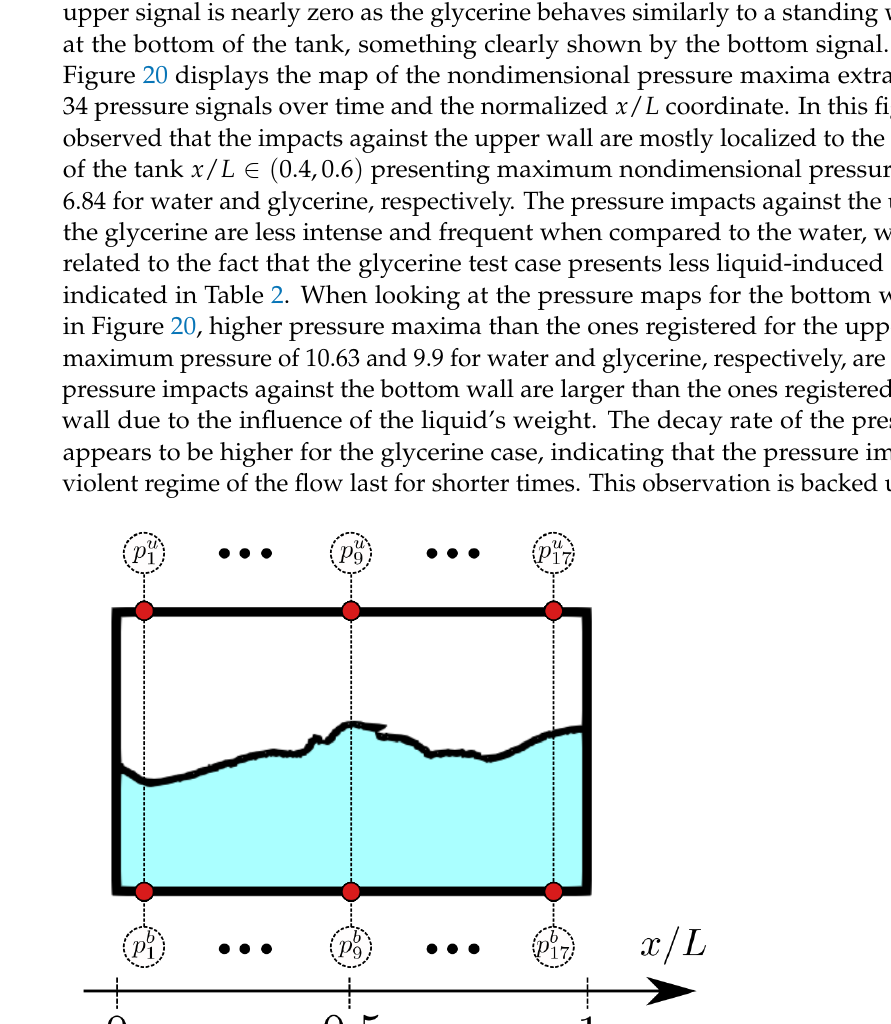
and p u ) for 9 9